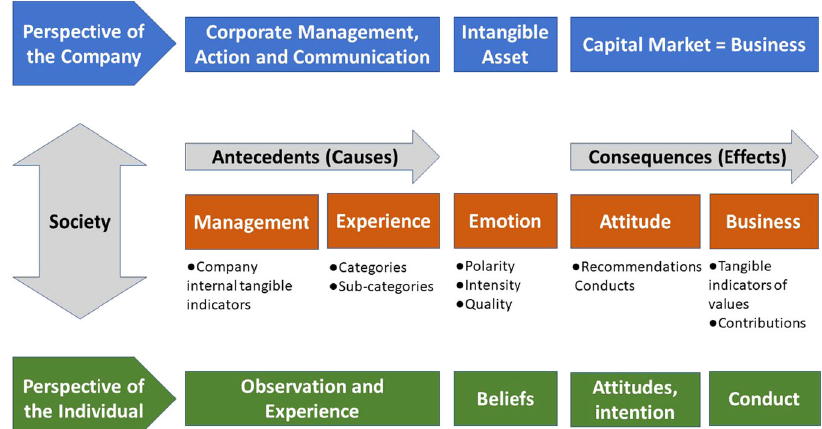
Fig. 1 Model for measurement and management of intangible assets GE2AN. Short description: the fi gure shows sa two-way management model that takes emotion as a central element, and can be used to determine which management action has caused a speci fi c impact on the organisation ’ s